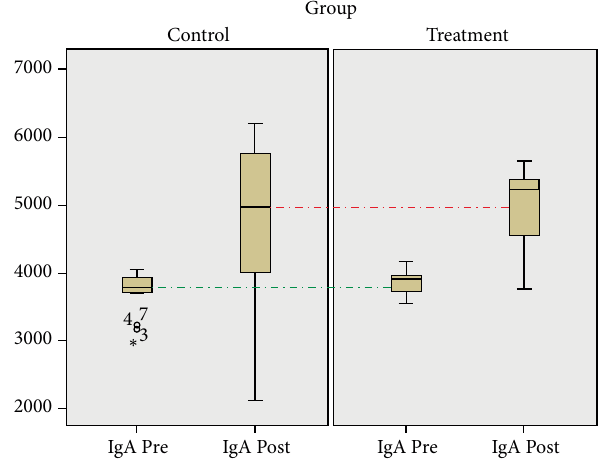
Figure 1: Boxplot IgA level before and after treatment.